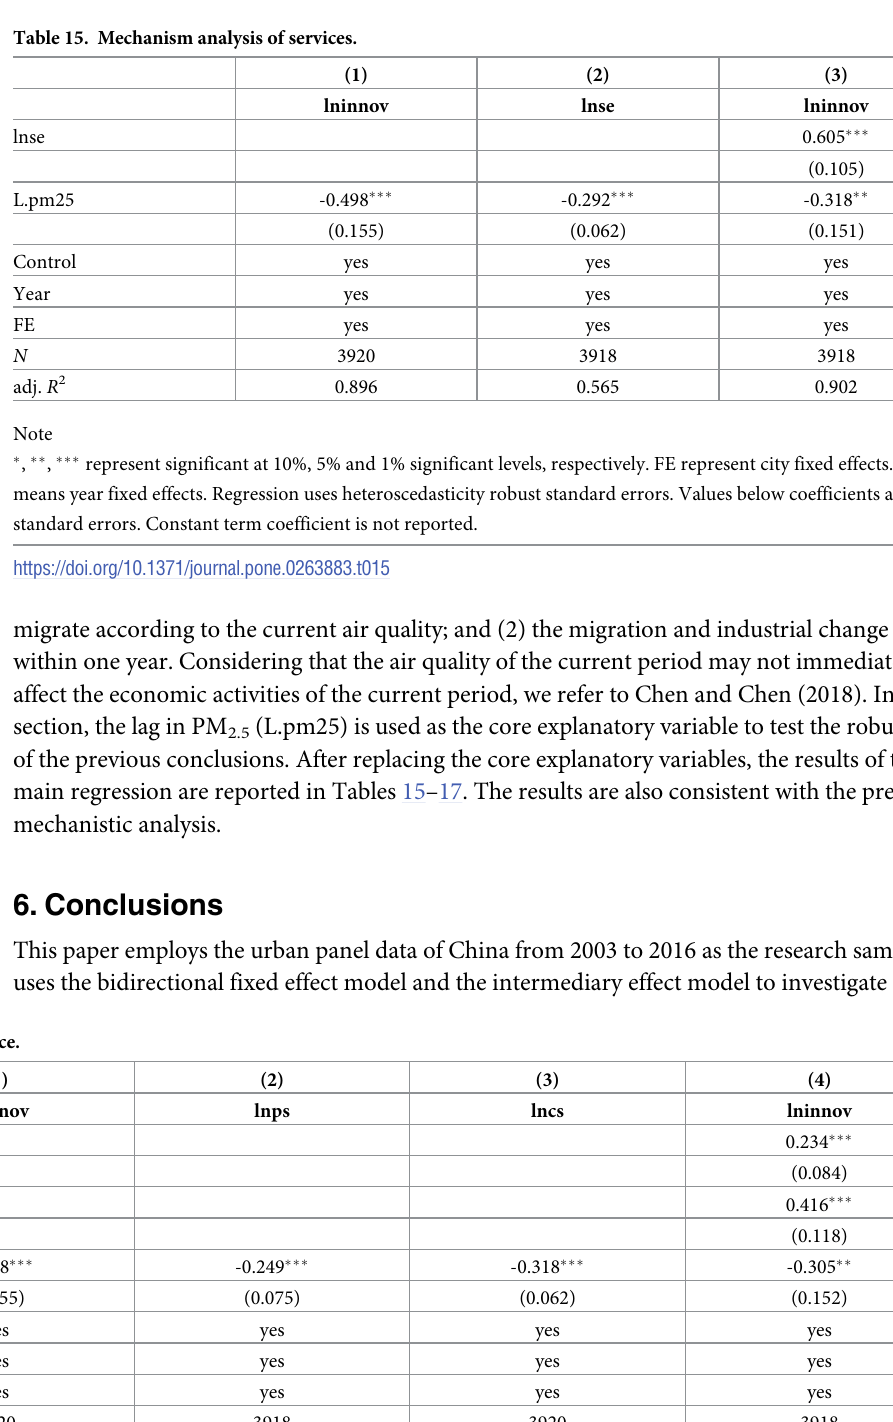
Table 15. Mechanism analysis of services.